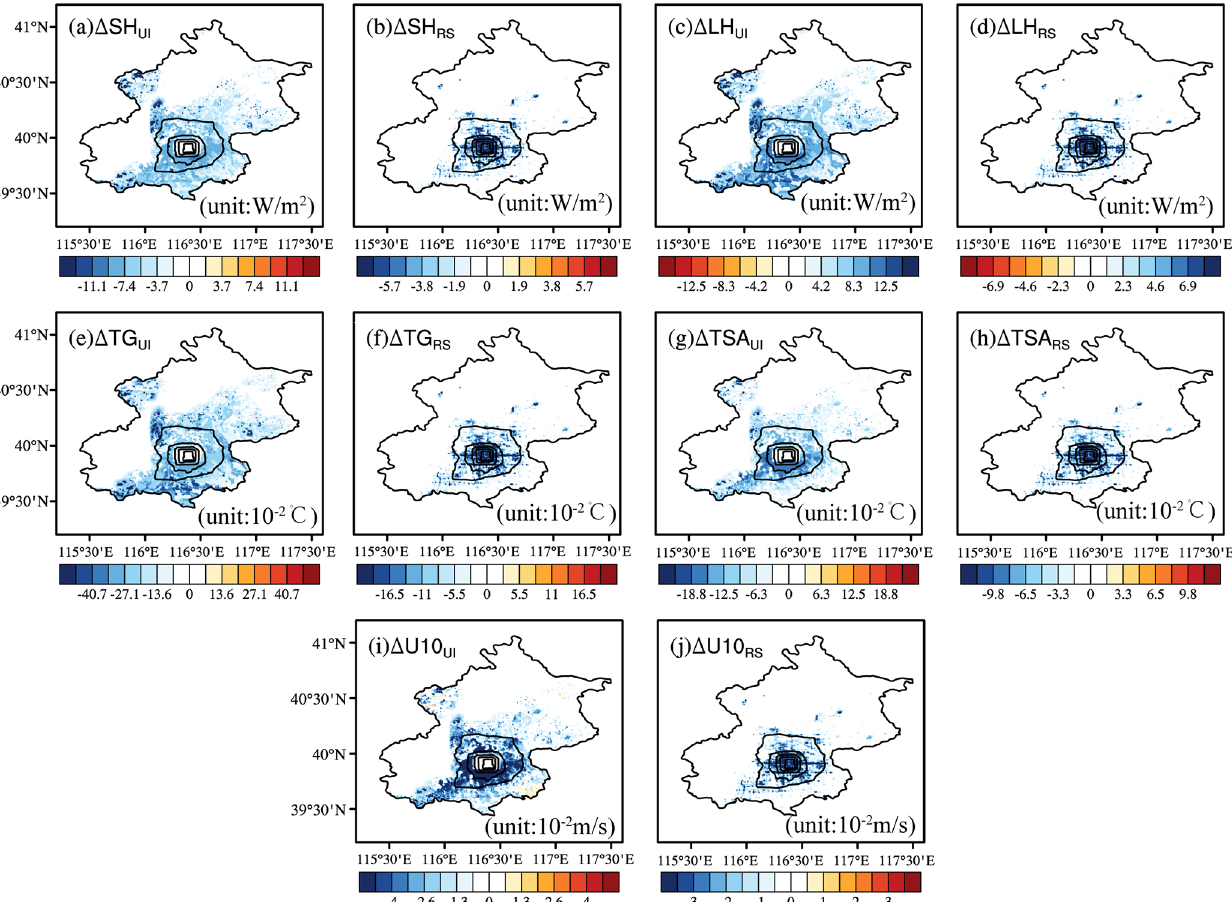
Figure 5. Changes in land surface variables due to urban irrigation (UI) and road sprinkling (RS). (a) Sensible heat flux under UI, (b) sensible heat flux under RS, (c) latent heat flux under UI, (d) latent heat flux under RS, (e) ground temperature under UI, (f) ground temperature under RS, (g) air temperature under UI, (h) air temperature under RS, (h) 10m wind speed under UI, and (j) 10m wind speed under RS.